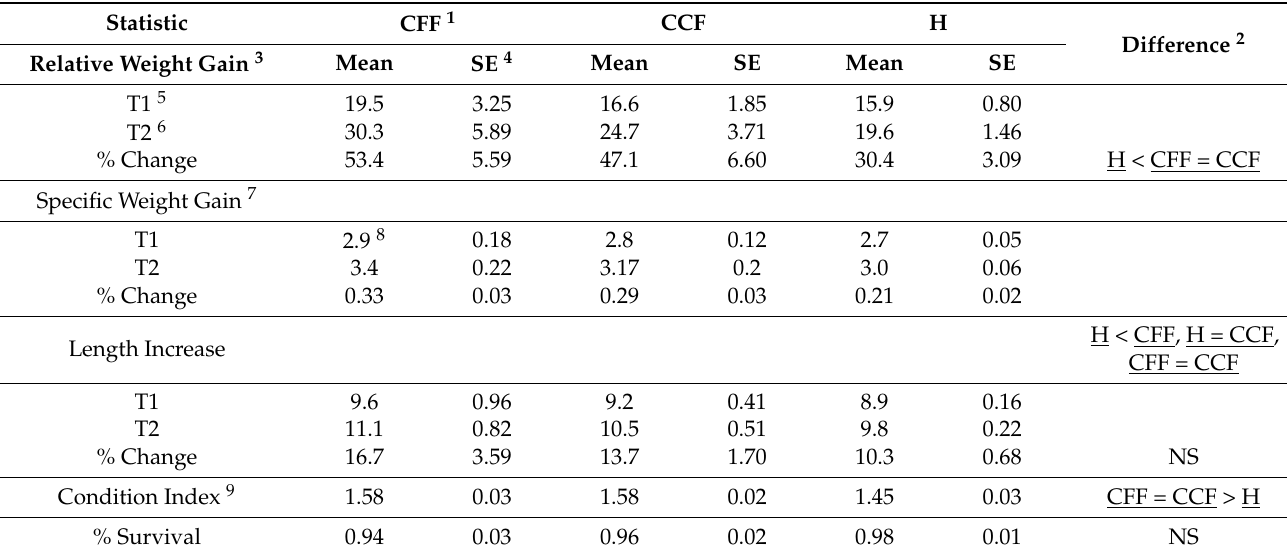
Table 5. Average growth in mass and length of individual common carp among